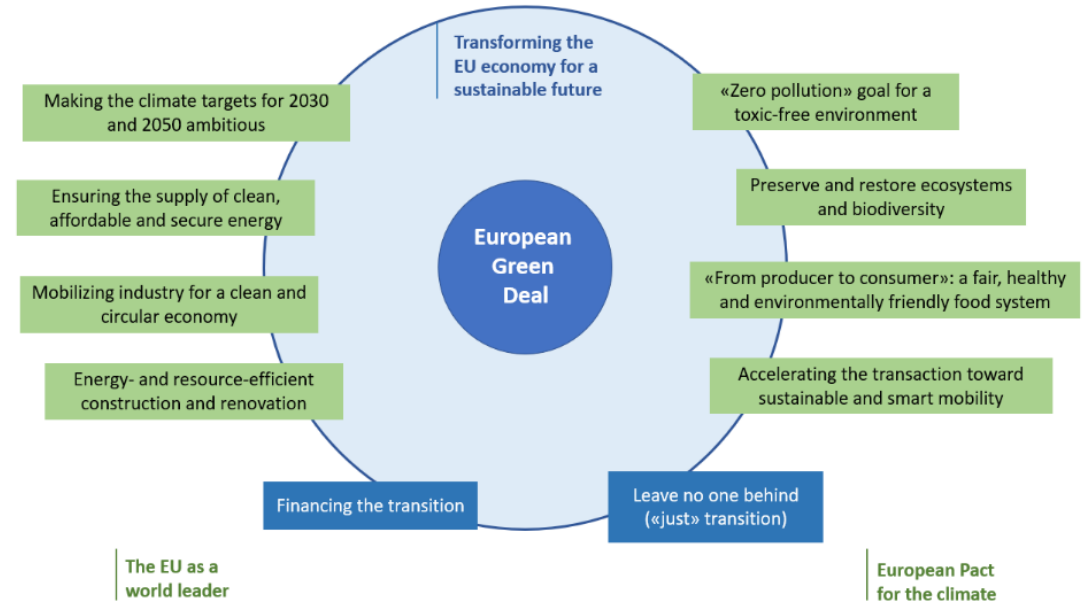
Figure 1. Various elements that comprise the European Green Deal.